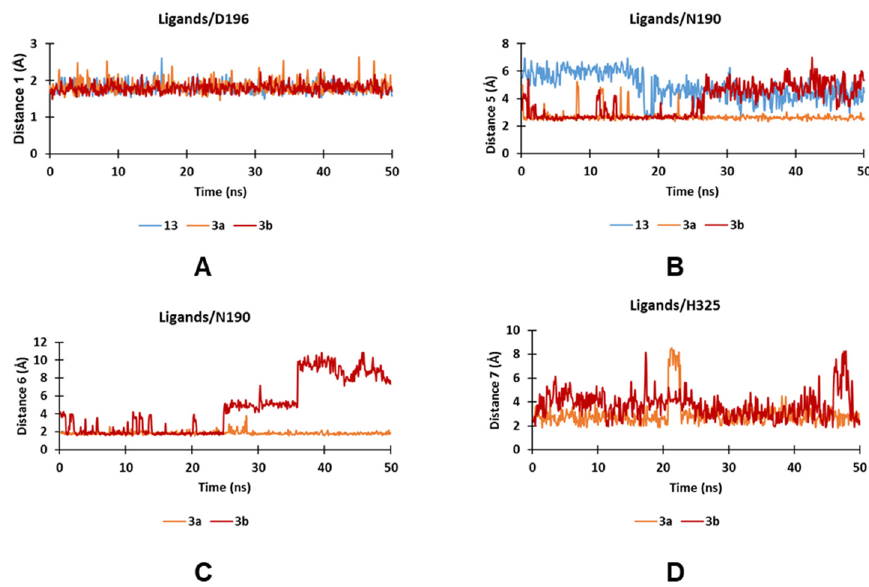
Figure 9. Time evolution of the most significant distances between binding-site residues of MraY AA and ligands atoms. ( A ) Distance d1 between the OD1 atom of D196 and the uridine NH moiety of ligands. ( B ) Distance d5 between the OD1 atom of N190 and the centroid of the amino group of ligands. ( C ) Distance d6 between the O atom of N190 and the H97 atom of the tartrate ligands. ( D ) Distance d7 between the HE1 atom of H325 and the O45 atom of the diamide ligands. (For the other distance measurements, see Supplementary Materials Figure S3.)